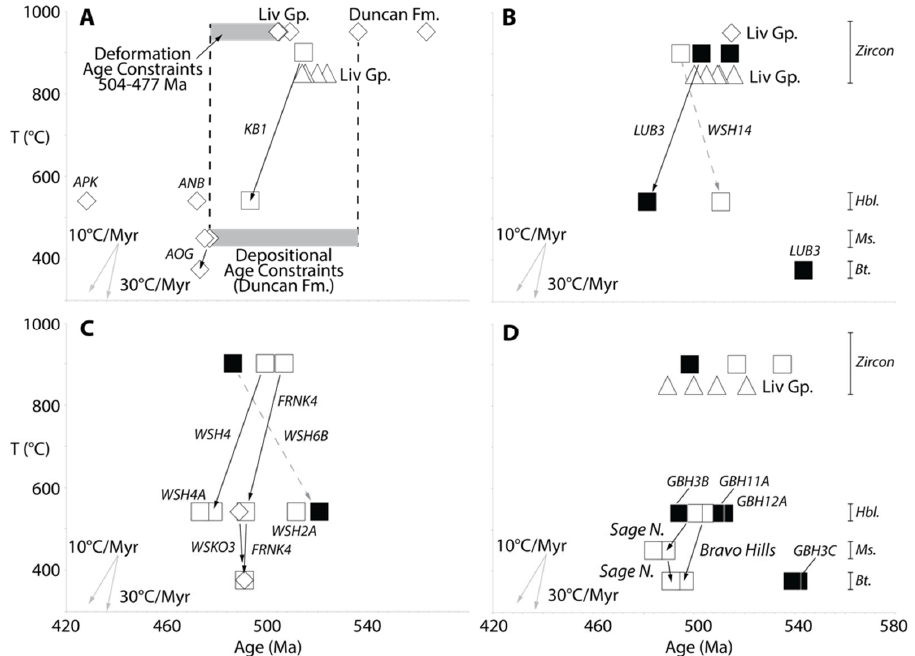
Figure 8. 40 Ar/ 39 Ar thermochronological data illustrating the cooling histories of metasedimentary (diamond) and foliated/pretectonic (open) and unfoliated ( fi lled) intrusive rocks (squares) with re- spect to U-Pb detrital zircon maximum depositional ages and U-Pb zircon crystallization ages for intrusive (squares) and volcanic (triangles) rocks in ( A ) Duncan Mountains, ( B ) upper Shackleton